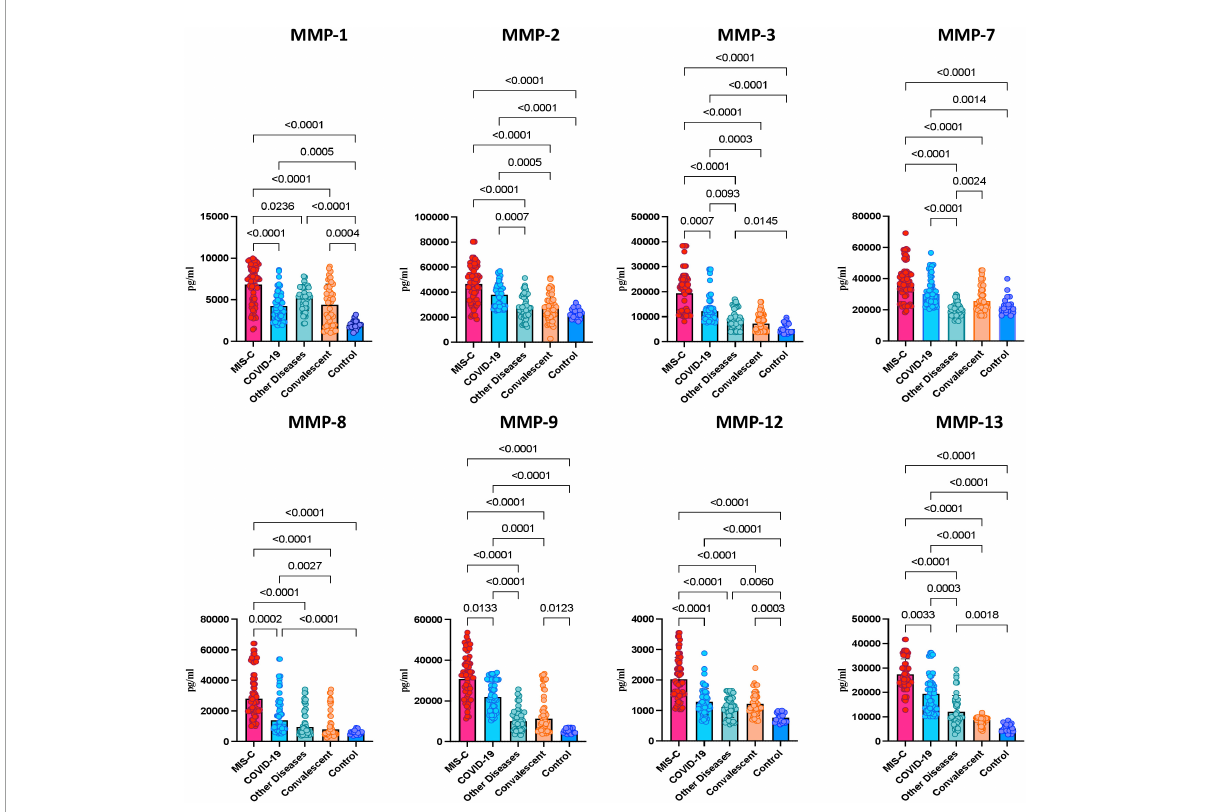
FIGURE1 Heightened plasma levels of matrix metalloproteinases (MMPs) in multisystem inflammatory syndrome in children (MIS-C) and acute COVID-19 children. The plasma levels of MMP-1, 2, 3, 7, 8, 9, 12 and 13 were measured in MIS-C ( n = 65), acute COVID-19 ( n = 56), children with other diseases ( n = 40), convalescent COVID-19 ( n = 47) and control children ( n = 21). The data are represented as scatter plots with each circle representing a single individual. p values were calculated using the Kruskal-Wallis test with Dunn’s post hoc for multiple